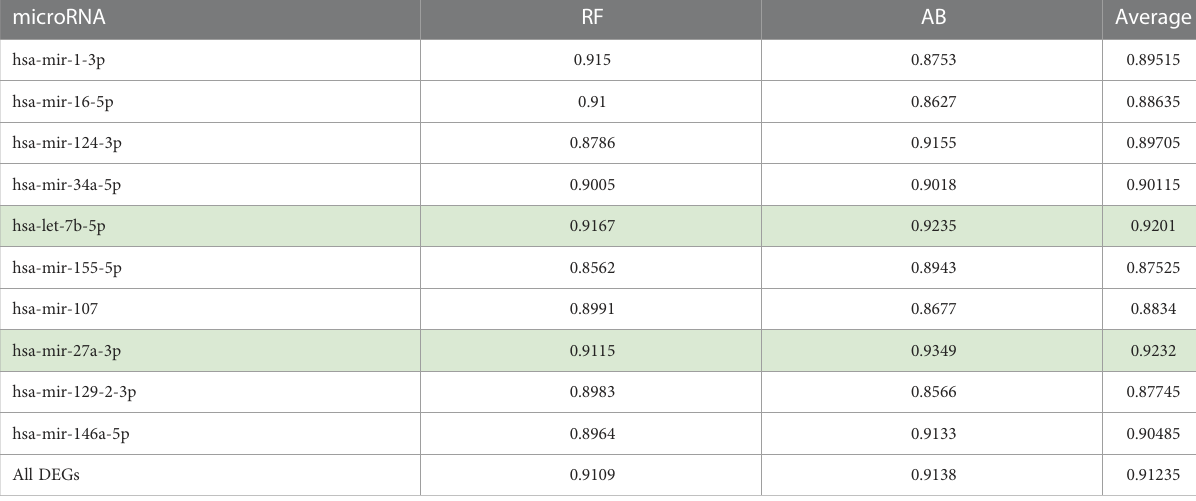
TABLE 2 Prediction performances achieved by RF and AB models using the targeted genes as